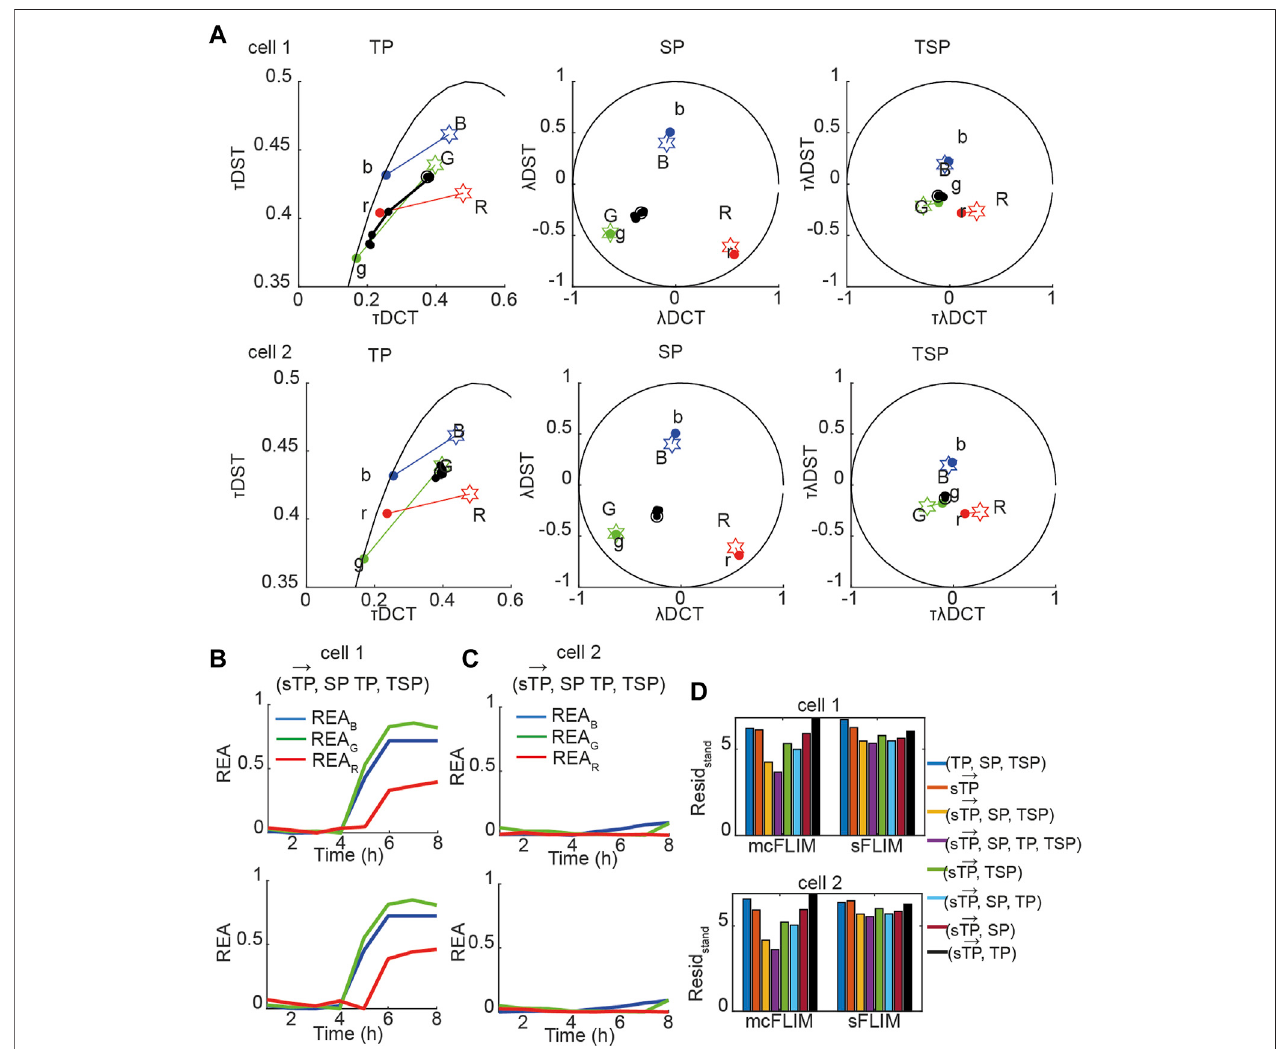
FIGURE 5 | Multidimensional phasor-based demixing of three biochemical reactions. (A) Time-lapse experiment showing two representative cells expressing all three sensors. Data are represented in the TP, SP, and TSP phasor subspaces. The black circles and lines represent the biochemical trajectory of a cell. Cells were treated with cisplatin and then imaged for 8 h every 1 h. Stars represent the reference fi ngerprints of the uncleavable sensors (labeled B , G , and R ), and colored circles (cid:1)(cid:1)(cid:1) → showthedonor-onlyreferences (labeled b , g ,and r ). (B,C) Theresultsofdemixingusing ( sTP , TP , SP ,and TSP )phasorsforsFLIM (top) andmcFLIM (bottom) for two different cells, respectively (see also Supplementary Figure S5 ). (D,E) The standardized phasor residuals summed over time for cell-1 (top) and cell-2 (bottom)